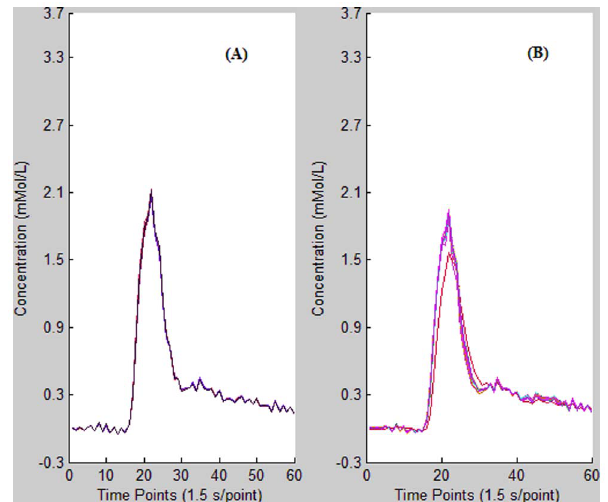
Figure 8. Comparison of AIF detection reproducibility for (A) K - means and (B) FCM clustering methods. Both algorithms were independently executed 50 times in succession. The robustness is 0.131 for the K -means method and 10.901 for FCM. Hence, K -means clustering shows better reproducibility than FCM for AIF detection.